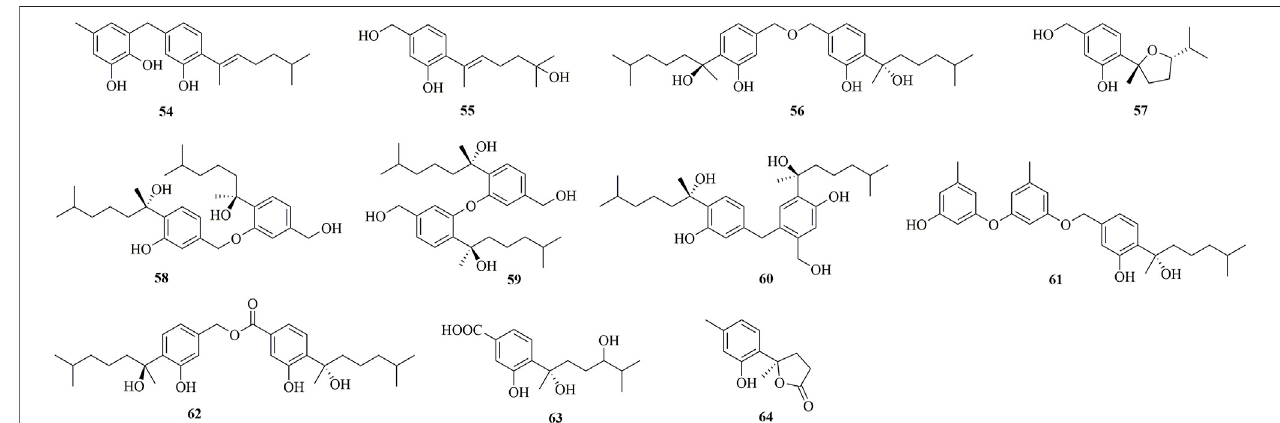
FIGURE 4 | Bisabolanes characterized from marine-derived fungi (Continued) ( 54 – 64